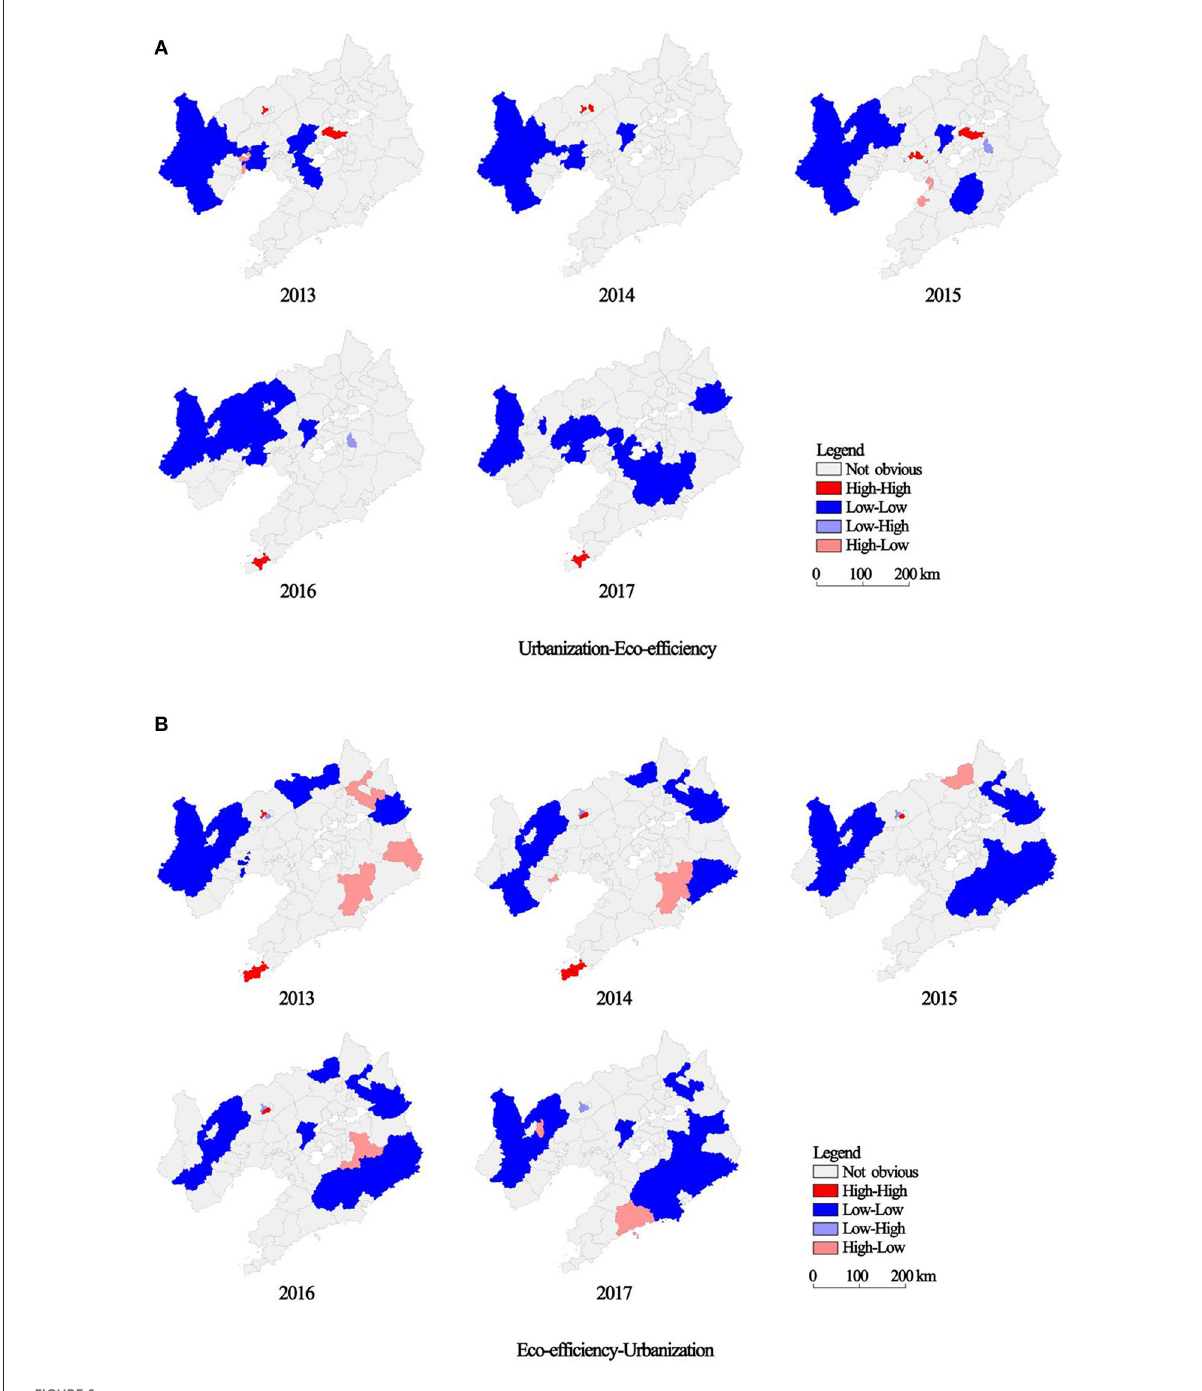
FIGURE6 LISA agglomerations of urbanization and eco-efficiency of agricultural counties and districts in Liaoning province (2013–2017). (A) Urbanization-eco-efficiency. (B) Eco-efficiency-urbanization.